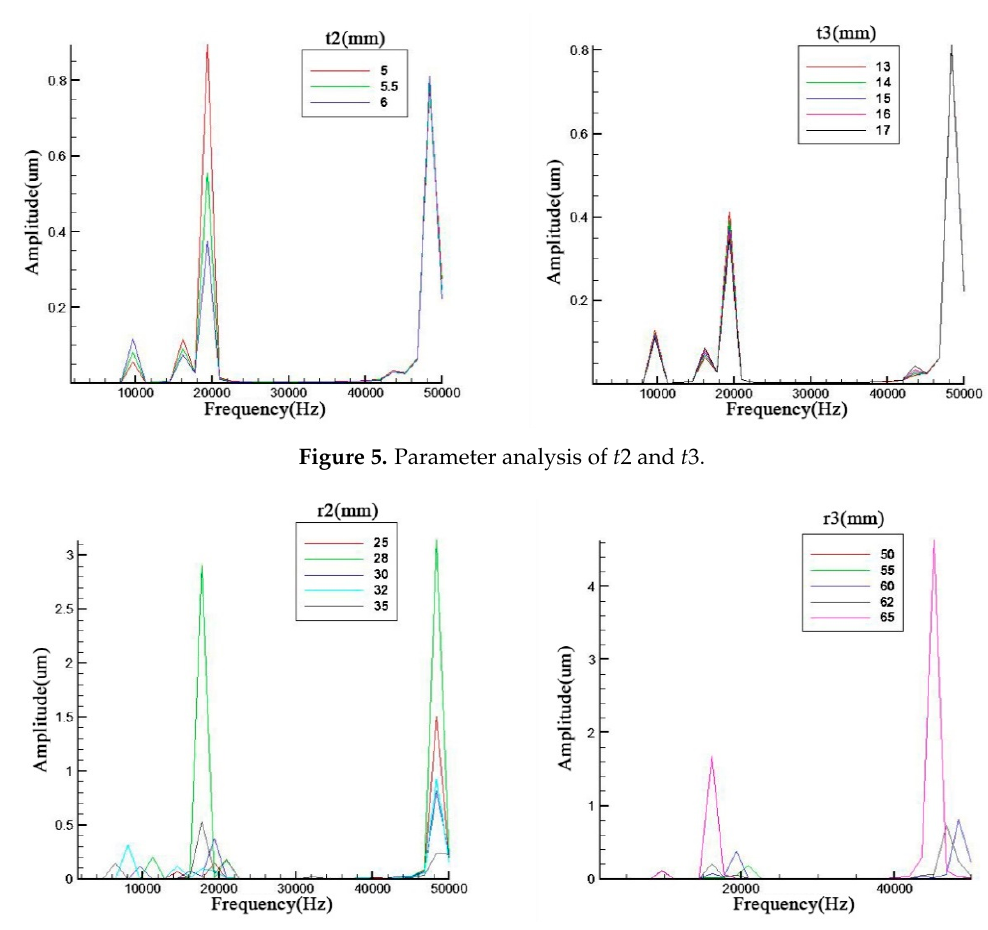
Figure 6. Parameter analysis of r 2 and r 3.